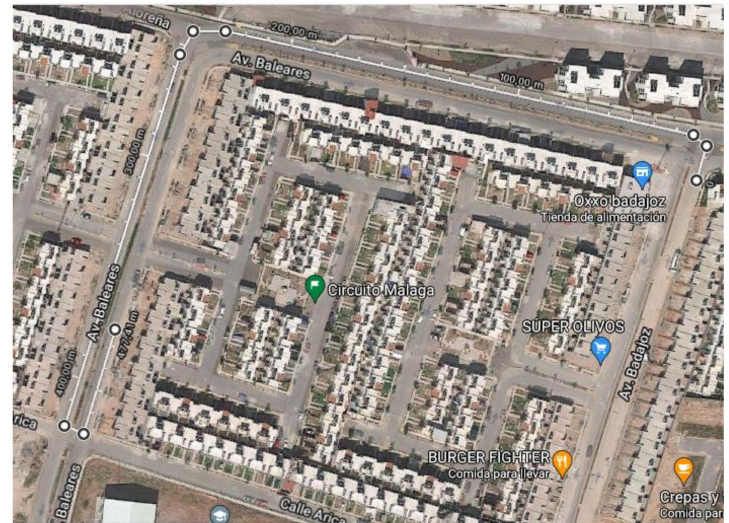
Figure 2. Route traveled (in white color). Source: https://www.google.com.mx/maps/@20.5515315, -100.7763127,176m/data=!3m1!1e3 (accessed on 28 January 2022). Map data © 2022